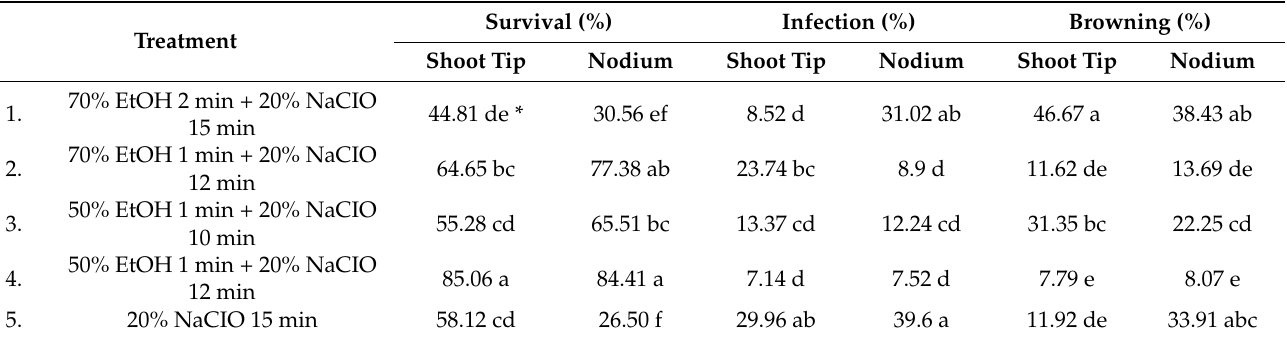
Figure 2. Epicormic shoot formation from the woody shoots of Arbutus unedo . Table 1. Effect of sterilization treatments with ethanol and sodium hypochlorite on the survival, infection, or browning of